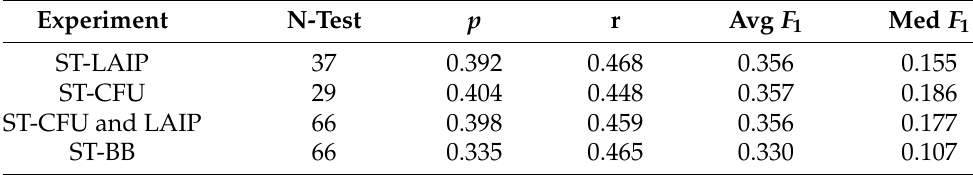
Table 1. Experimental results for the supervised approach based on the Set-Transformer (ST) [17]. A patient cross validation was performed and thus the train and validation set change per patient. Experiments were conducted for the backbone marker (BB) as well as the full 8-color LAIP and CFU panel.